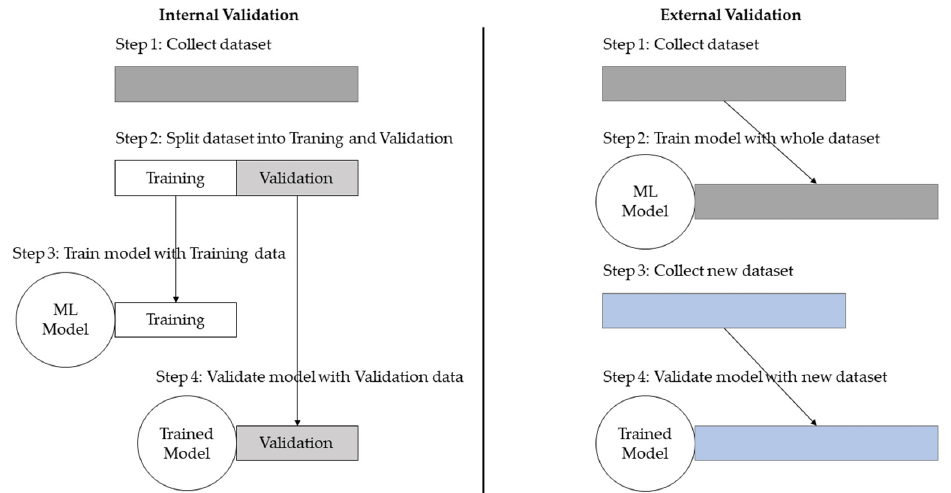
Figure 6. Internal vs. external validation. Internal validation uses one dataset and splits it into training and validation, the ML model is then trained and validated on the same dataset resulting in higher risk of overfitting. External validation uses one dataset for training and a meaningfully different dataset for validation. When (geographically) different datasets are used, the risk of overfitting can be significantly reduced.